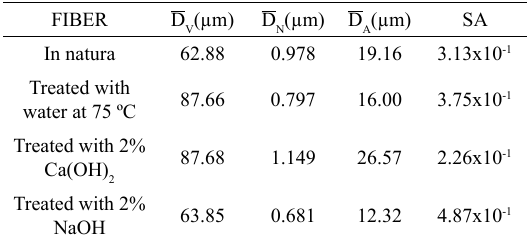
Figure 5. Particle size of the fibers: "In natura", treated with Ca(OH) NaOH and with hot water at 75ºC. Table 3. Fiber diameters.